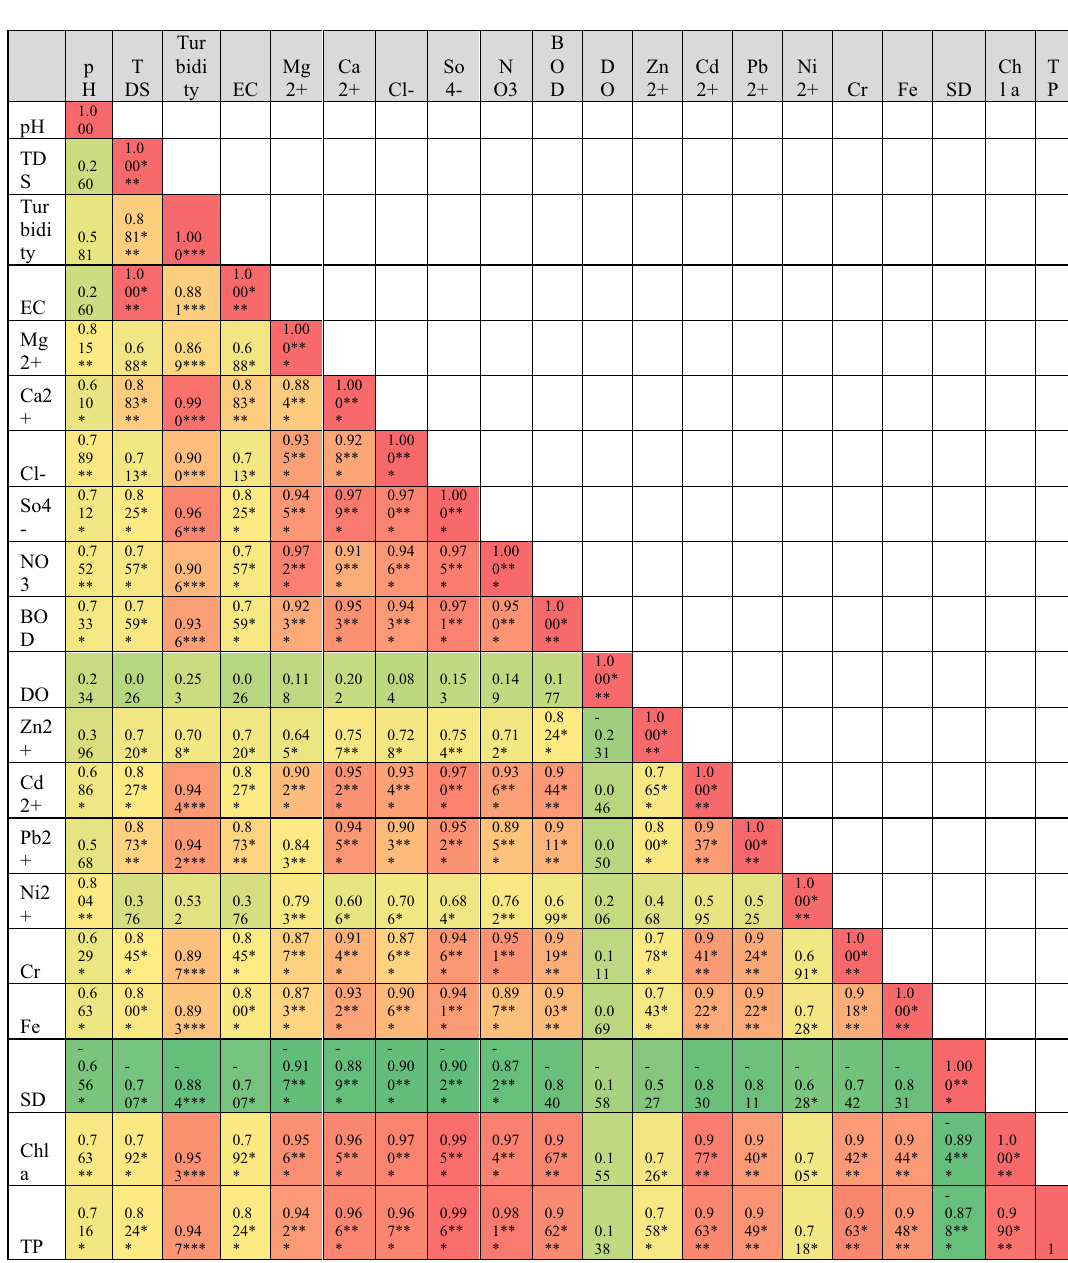
Table 2. Pearson correlation matrix of water quality parameters (significant at p < 0.05*, p < 0.01**, p < 0.001***), (a) pre-lockdown (November 2020); (b) during-lockdown (July 2020) and after unlock phase (November 2020). Red colour = + positive relation; green colour = -negative